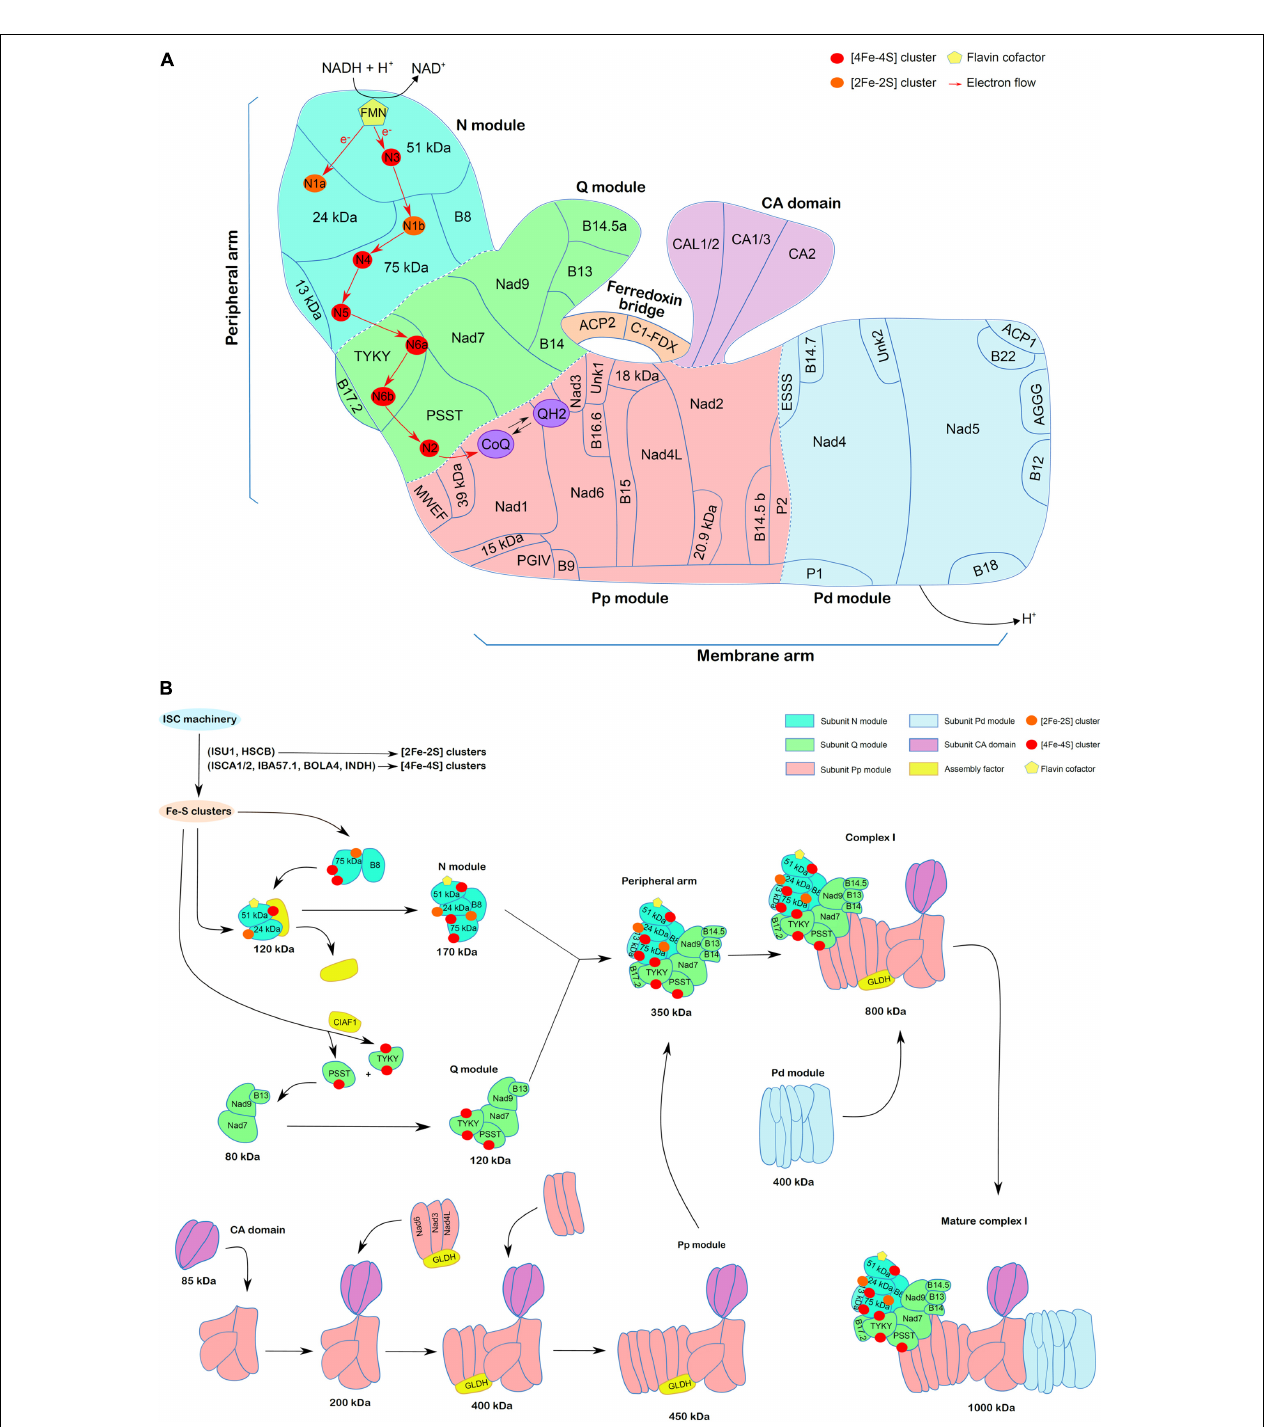
FIGURE 1 | Complex I structure and assembly in plants. (A) Schematic representation of complex I structure based on the 3D structure of Brassica oleracea complex I (Soufari et al., 2020), including the ferredoxin bridge described in Klusch et al. (2021). Arabidopsis nomenclature is used for the 46 subunits shown here. The CA domain, ferredoxin bridge, modules of the peripheral arm (N and Q modules) and of the membrane arm (Pp and Pd modules) have been represented in different colors. The electron flow from FMN to coenzyme Q via the 7 Fe-S clusters present in the different subunits of the peripheral arm is shown. (B) Model of the assembly steps of complex I. The figure is adapted from Ligas et al. (2019). Emphasis is made on Fe-S cluster-containing subunits present in the N and Q modules of the peripheral arm. It is thought that they are assembled prior to their insertion in larger subassemblies. Both [2Fe-2S] clusters (orange) and [4Fe-4S] clusters (red) are synthesized via the mitochondrial ISC machinery but HSCB and ISCU1/3 scaffold proteins may be sufficient for [2Fe-2S] clusters whereas additional maturation